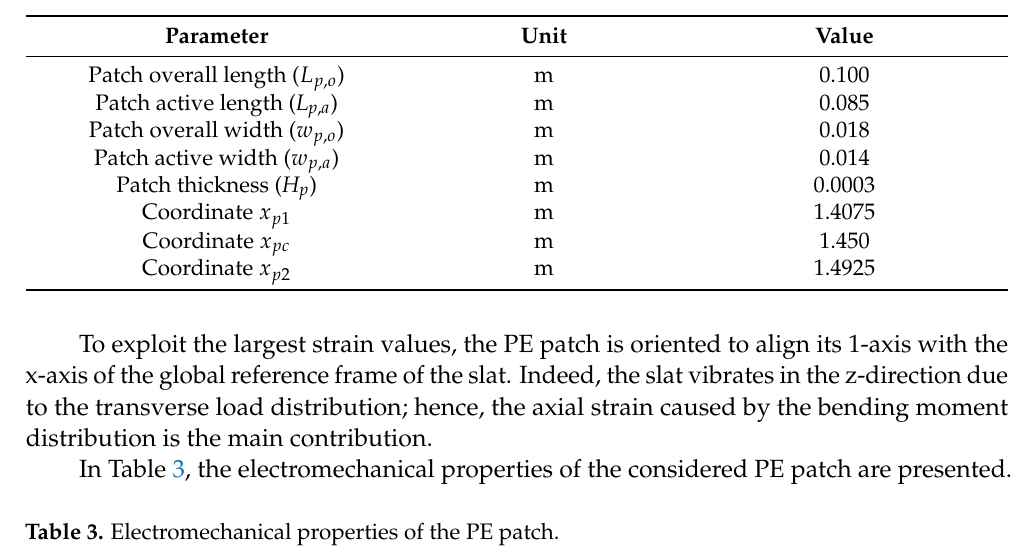
Table 2. Geometrical parameters of the PE patch.